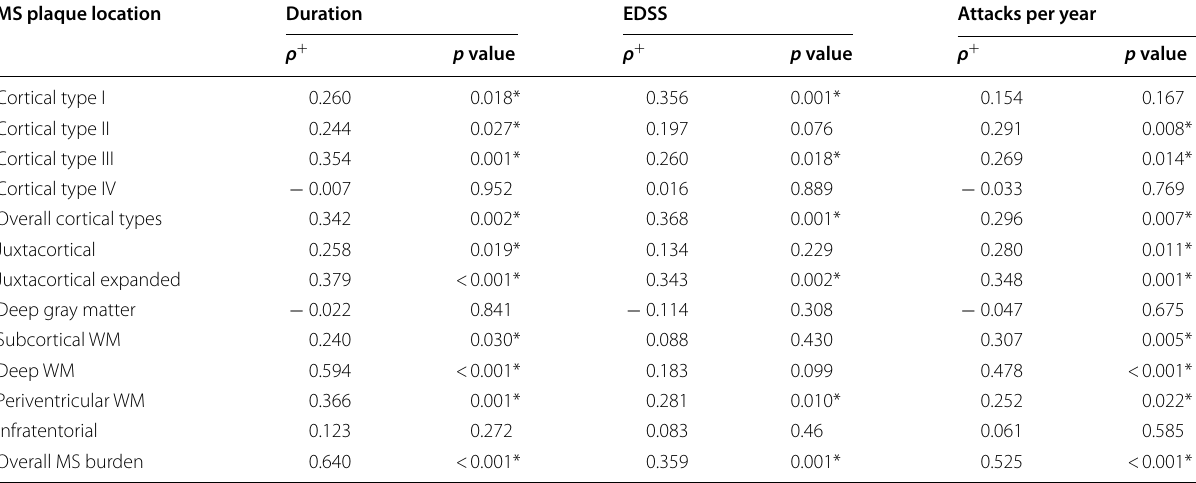
Table 3 Correlation between duration of disease, EDSS and the number of attacks per year and the number of MS plaques in different anatomical